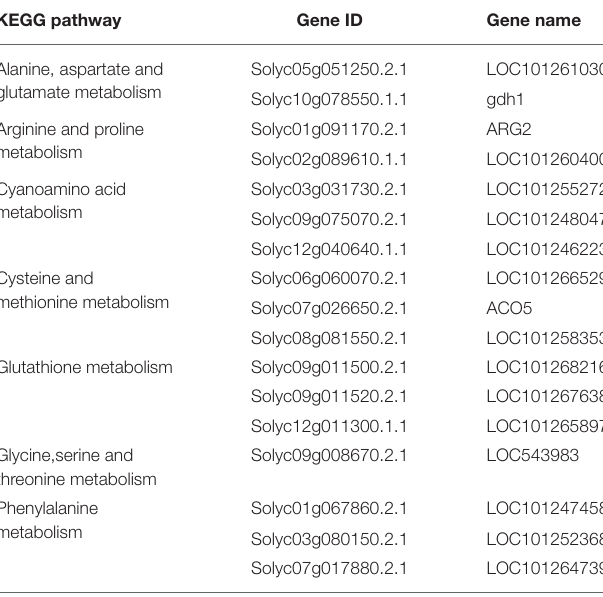
TABLE 5 | Carbohydrate metabolic pathway enrichment analysis of differentially displayed genes.